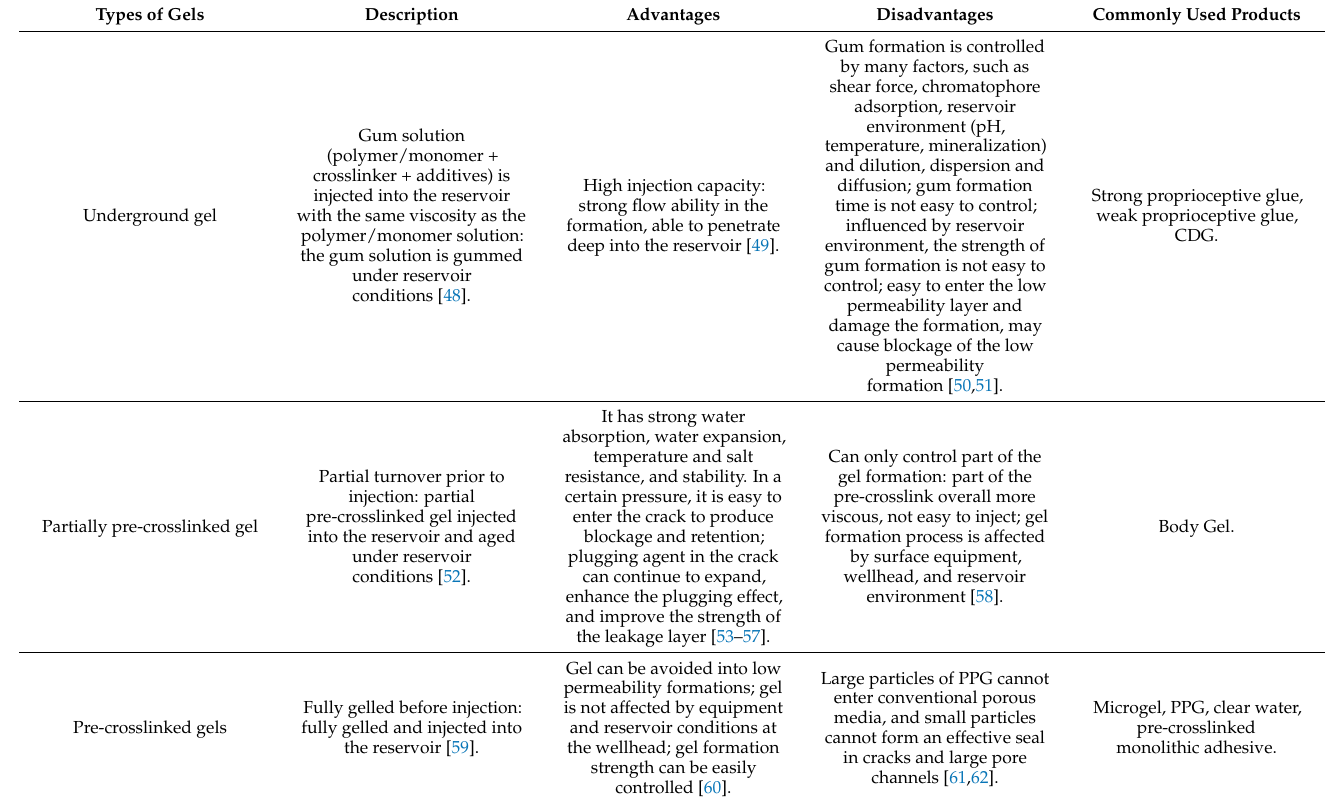
Table 1. Advantages and disadvantages of three common IPG systems and typical